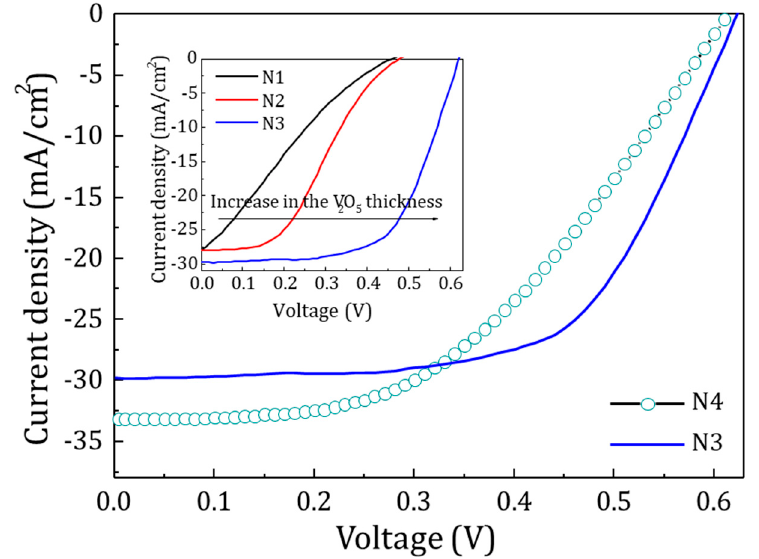
Figure 10. J-V curve measured under AM 1.5 irradiance (100 mW / cm 2 ). N1, N2, N3 represents the devices with thickness of the V 2 O 5 layer as 25 nm, 35 nm, 50 nm and N4 without the metallic layer. Higher V oc of 631 mV for device structure N3 confirms the high capability of AZO / Ag:Al / V 2 O 5 structures over the other transparent electrodes. Table 2. The photovoltaic parameters (Open ‐ circuit voltage V oc , short ‐ circuit current density J sc , Fill factor FF, Photovoltaic conversion efficiency η ) of the solar cells fabricated. N1, N2, N3 are the cells with V 2 O 5 layer thicknesses 25 nm, 35 nm, 50 nm respectively. N4 is the cell without the Ag:Al metallic layer with 50 nm thickness of V 2 O 5 layer. The increase in the V oc and FF of the cells could be observed as the thickness of the V 2 O 5 increases. A huge decrease in the FF is observed in N4 due to the high sheet resistance of the layers.